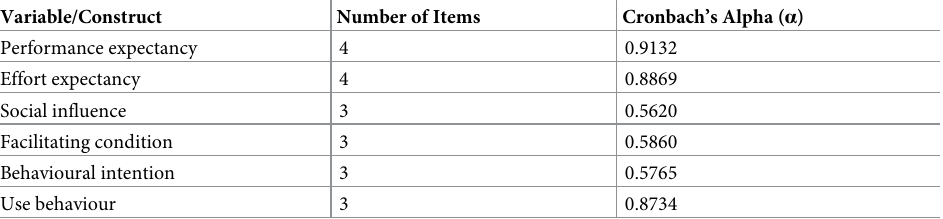
Table 1. Results of cronbach alpha reliability.